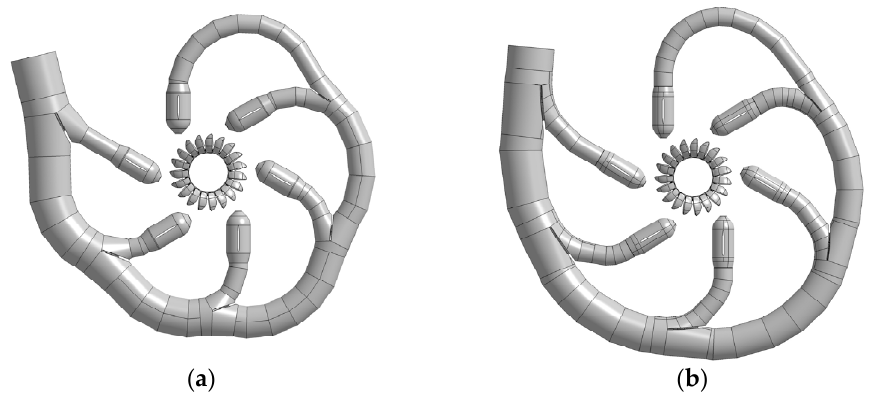
Figure 1. The layout of the turbine: ( a ) baseline design; ( b ) final design.